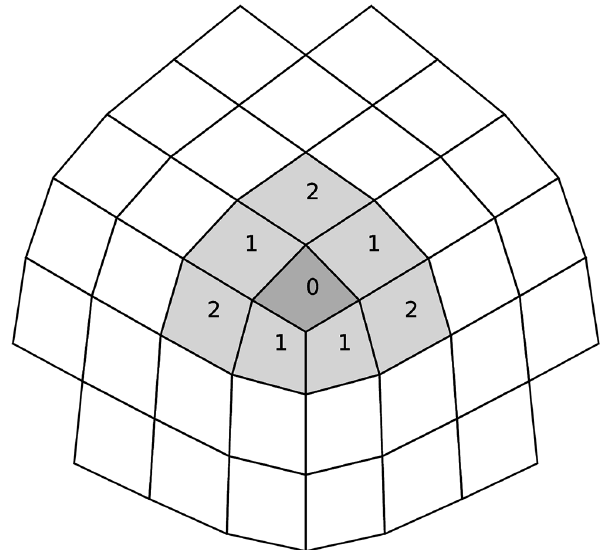
Figure 2. Stencil for a quadratic reconstruction of a field around the corner of a cubed sphere. Numbers indicate at which iteration of the stencil generation the cell is added, lightly shaded cells indicate cells used for the reconstruction that are fitted in a least squares manner, and the darkly shaded cell indicates the central cell which is fitted